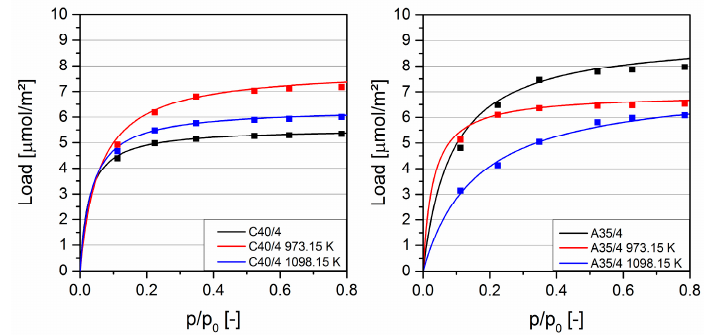
Figure 3. TGA adsorption measurements of acetone at 298.15 K (symbols: measuring data (Table S1), lines: fitted Langmuir isotherm (Table S2)).